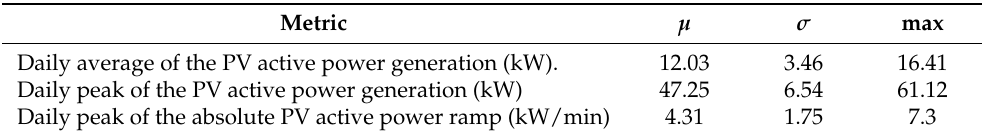
Table 7. Metrics of the PV generation profile during May 2020. µ : average value, σ : standard deviation, max: maximum